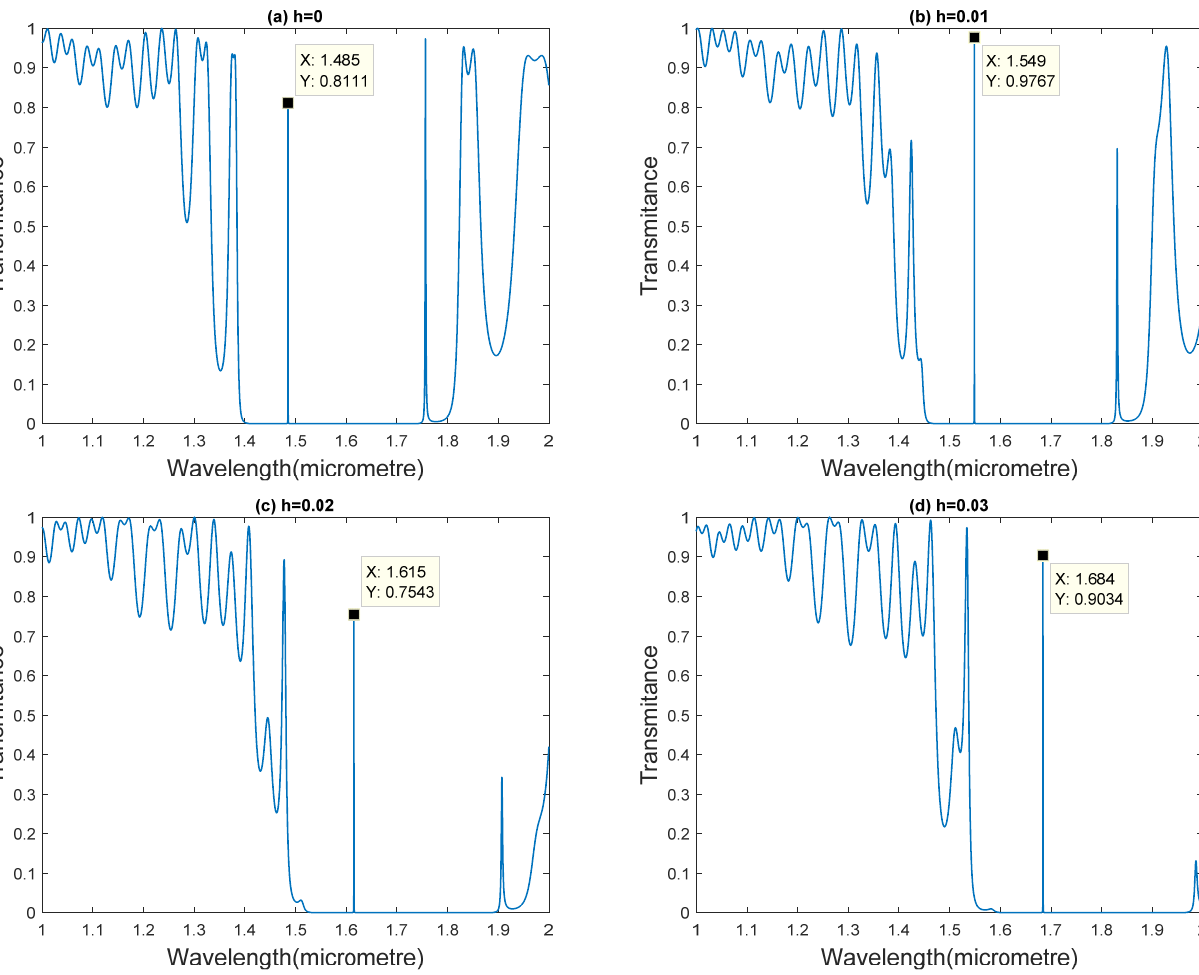
Figure 3. Variation of the transmittance peak intensity ( a ) and the quality factor ( b ) as functions of the layer number ( P ) of a photonic structure with P alternated layers of fused silica and TiO 2 and with a middle cavity filled with seawater of 50% salinity and at room temperature.